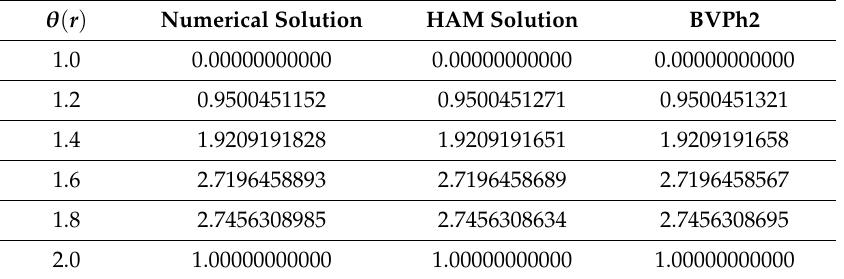
Table 2. Comparison of numerical, HAM, and BVPh2 methods for temperature